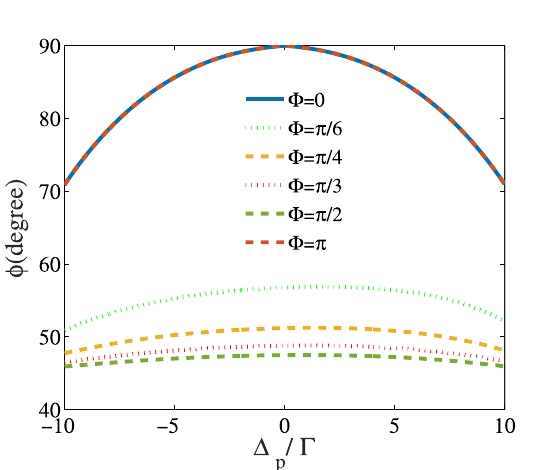
Figure 7. MOR angle of the polarization direction of the linearly polarized probe field versus Ω other taken parameters are Ω = . Γ 0 01 and Φ = 0 .